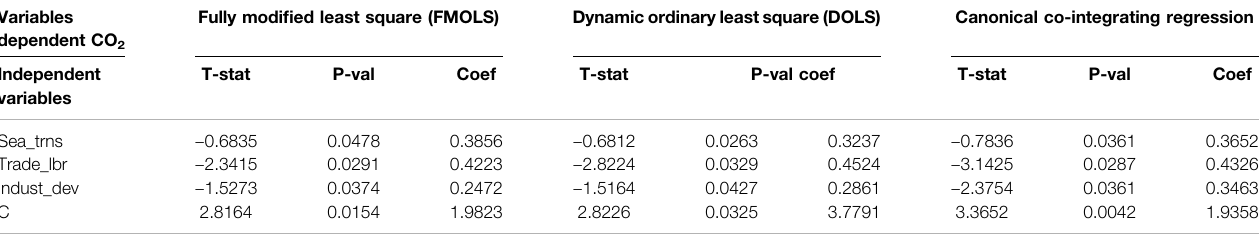
TABLE 3 | Cointegration estimation results (FMOLS, DOLS and CCR models of China).